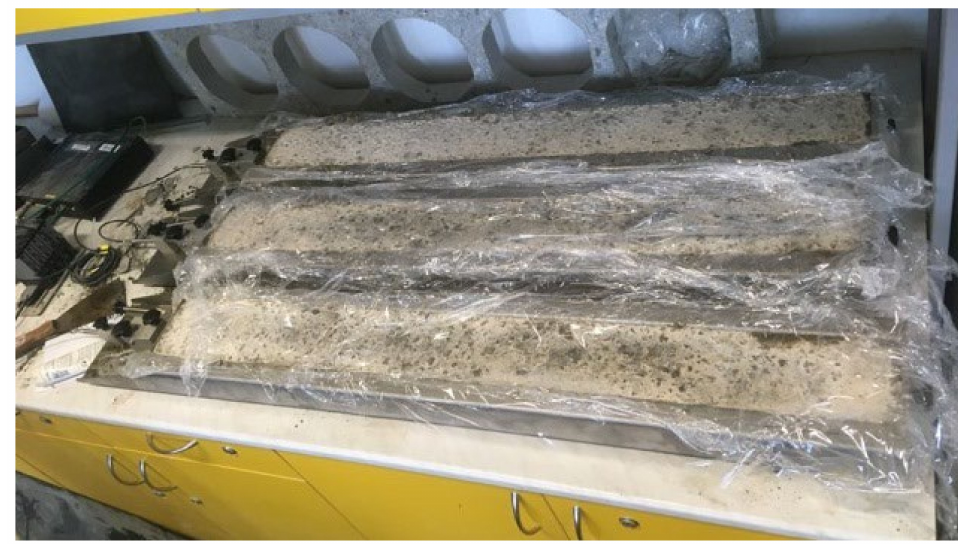
Figure 15. Test equipment during the measurement of volume changes in measuring